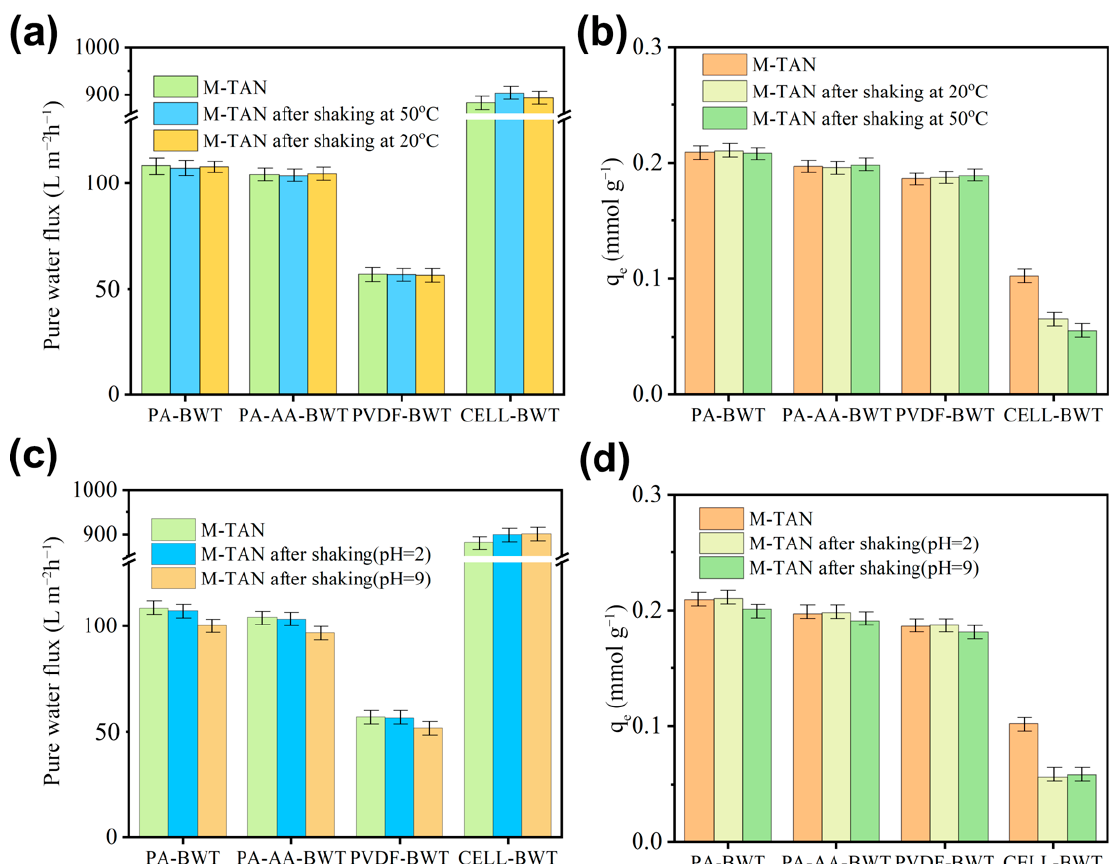
Figure 6. Water flux and adsorption capacity of different M-TANs before and after long-term shaking and soaking at ( a , b ) different temperatures and ( c , d ) pH.